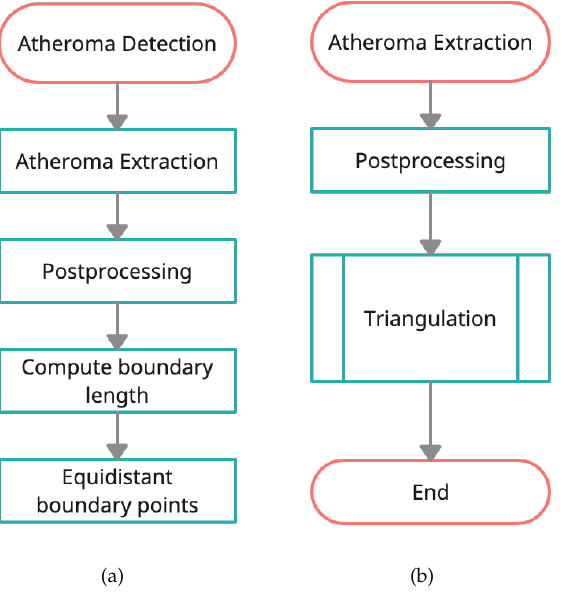
Figure 4. ( a ) Flowchart of the atheroma extraction step; ( b ) Flowchart of the postprocessing